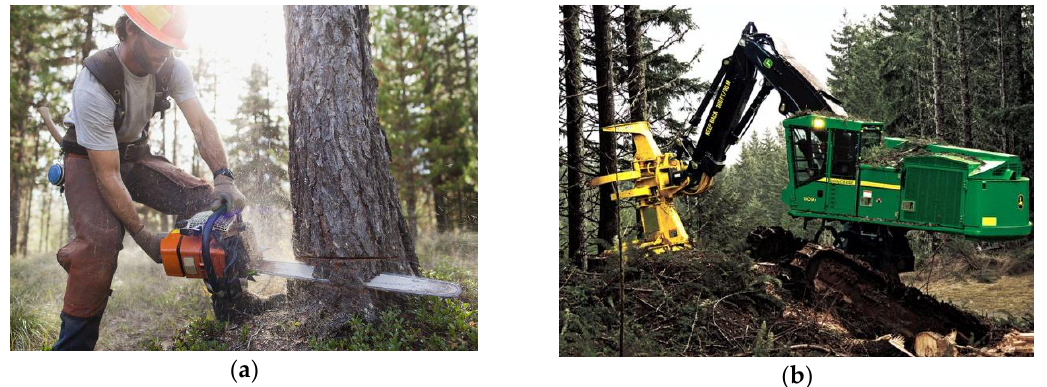
Figure 1. The primary logging systems for felling trees: ( a ) conventional chainsaw felling and ( b ) heavy mechanical equipment felling using a feller-buncher.